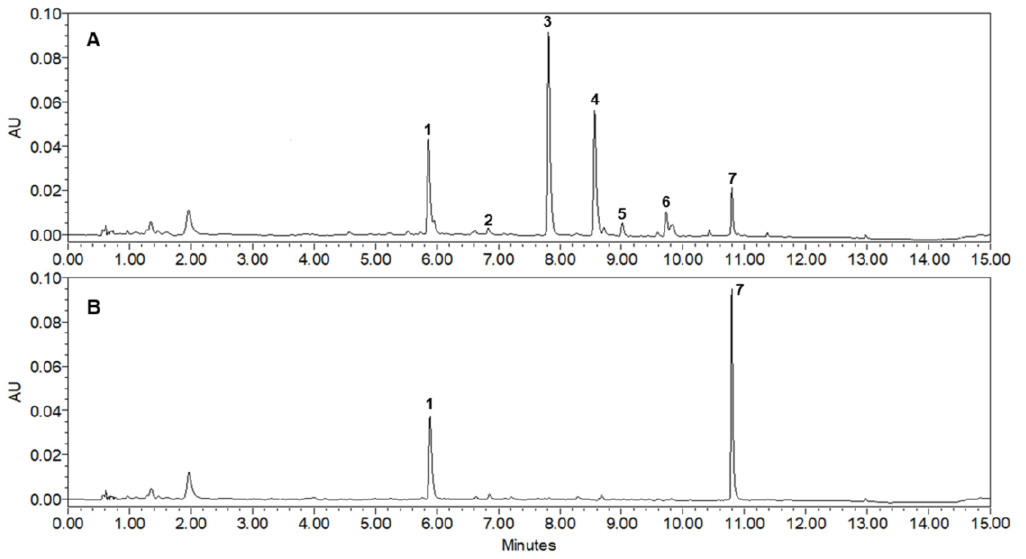
Figure 4. UPLC-PDA chromatograms of 50% EtOH extract from the aerial parts of A. rugosa (265 nm): ( A ) Control of 50% ARE; ( B ) hydrolysis of 50% ARE with 0.2 units of β -glucosidase. The order of peaks ( 1 − 7 ) is: 1 . rosmarinic acid, 2 . salvianolic acid B, 3 . tilianin, 4 . acacetin 7- O - (6″ - O -malonyl)- β -D-glucopyranoside, 5 . acacetin 7- O - (2″ - O -acetyl)- β -D-glucopyranoside, 6 . acacetin 7- O - (2″ - O -acetyl- 6″ - O -malonyl)- β -D-glucopyranoside, and 7 . acacetin.